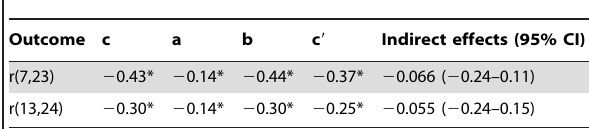
Table 6. Mediation analyses for the relationships of age group on the strength of functional network connectivity between independent components via global brain volume.